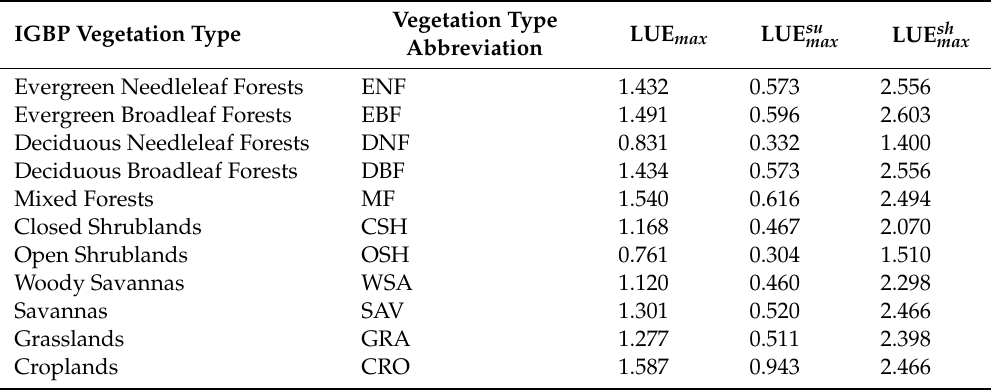
Table 1. LUE max , LUE su max and LUE sh max for each vegetation